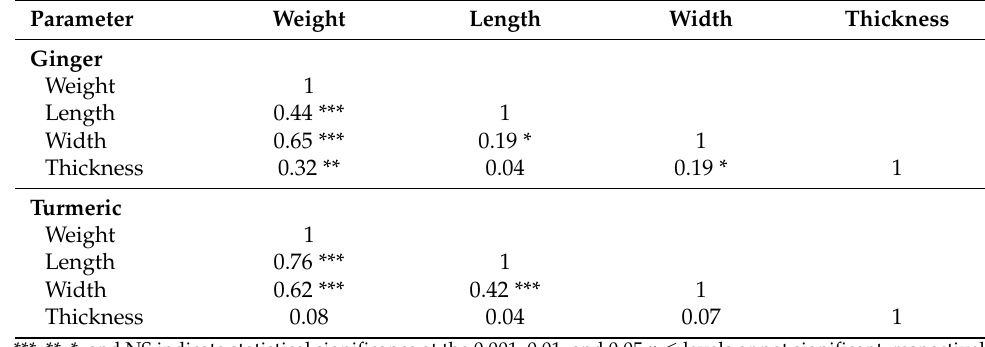
Table 5. Analysis of covariance on the effect of the temperature and morphological parameters on the sprouting of ginger and turmeric seed rhizomes from the calibration experiment. p -Value Reg. Coef.